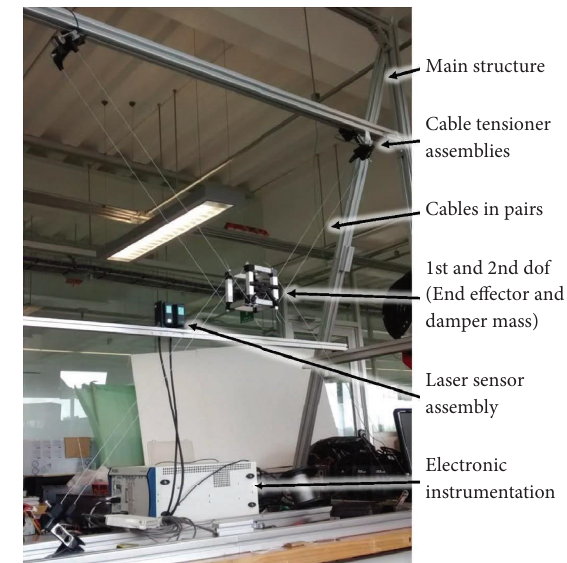
Figure 6: Photography of the experimental